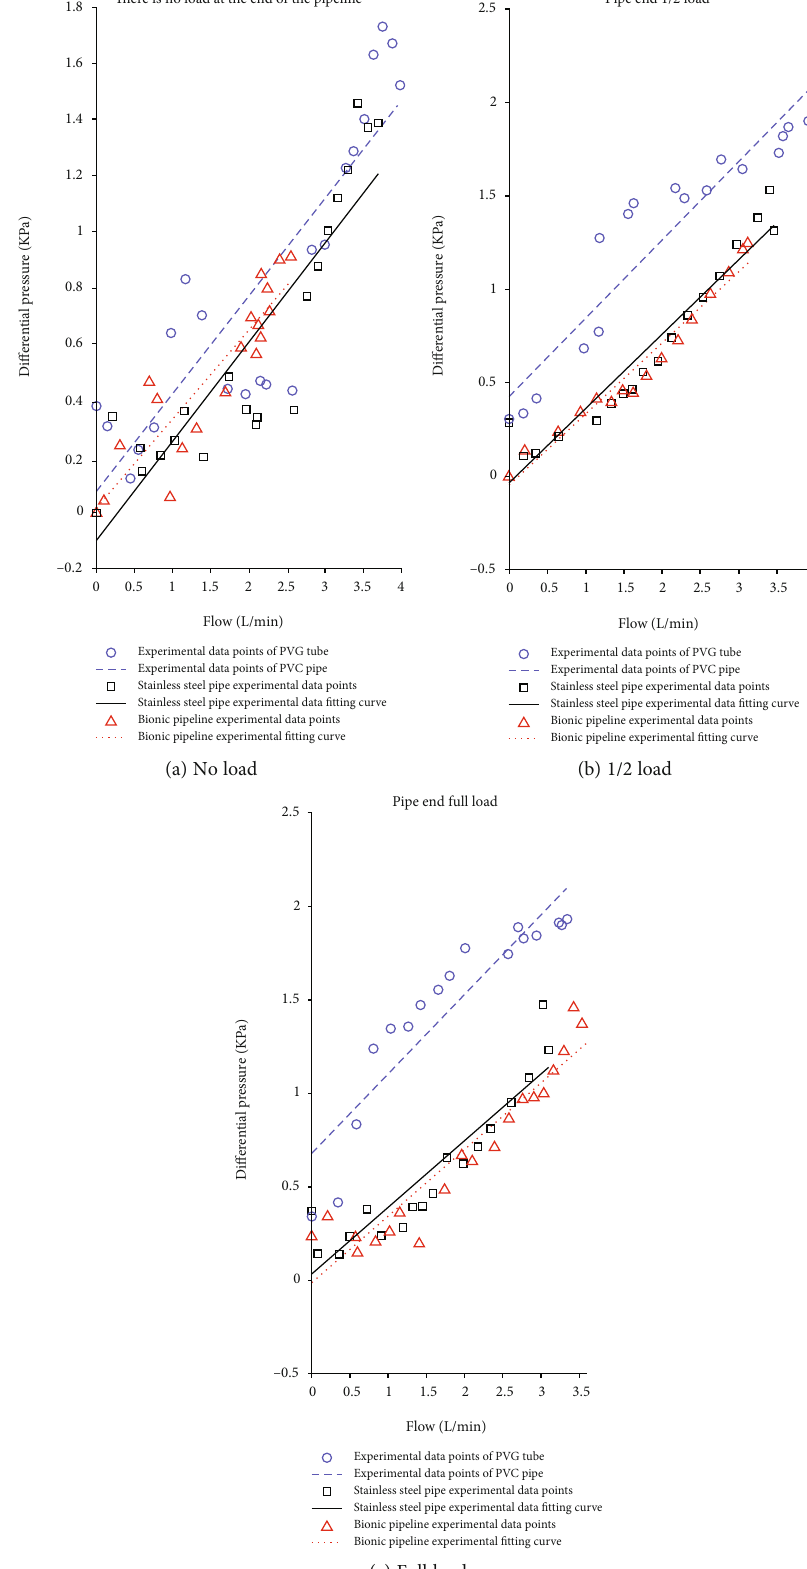
Figure 11: Flowing liquid-puri fi ed